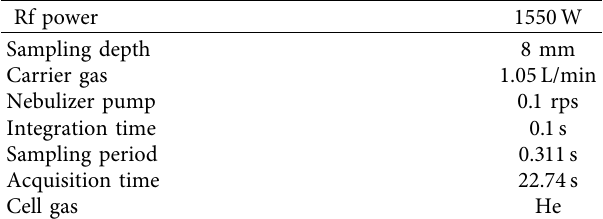
Table 2: Operating conditions for the Agilent 7900